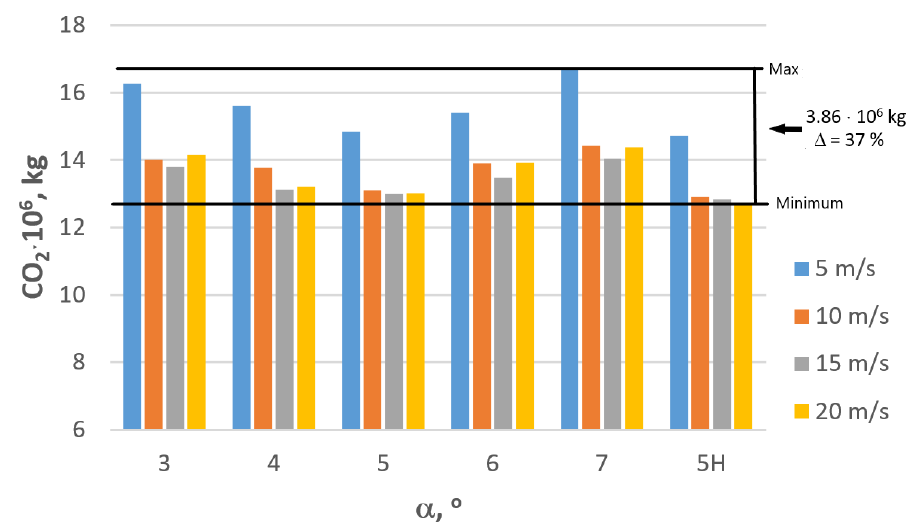
Figure 13. Influence of the technology of wire manufacturing on the CO 2 emissions caused by energy consumption in relation to the production of 100,000 tons of steel wire drawn with v = speed 5, 10, 15, 20 m/s.